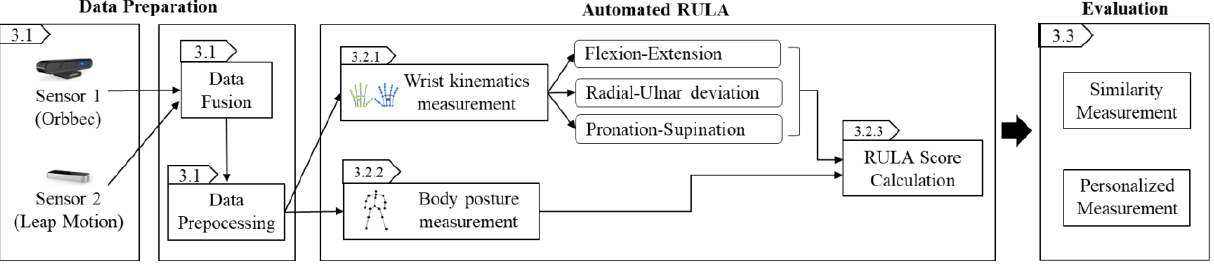
Figure 1. Workflow of Ergonomics Assessment.